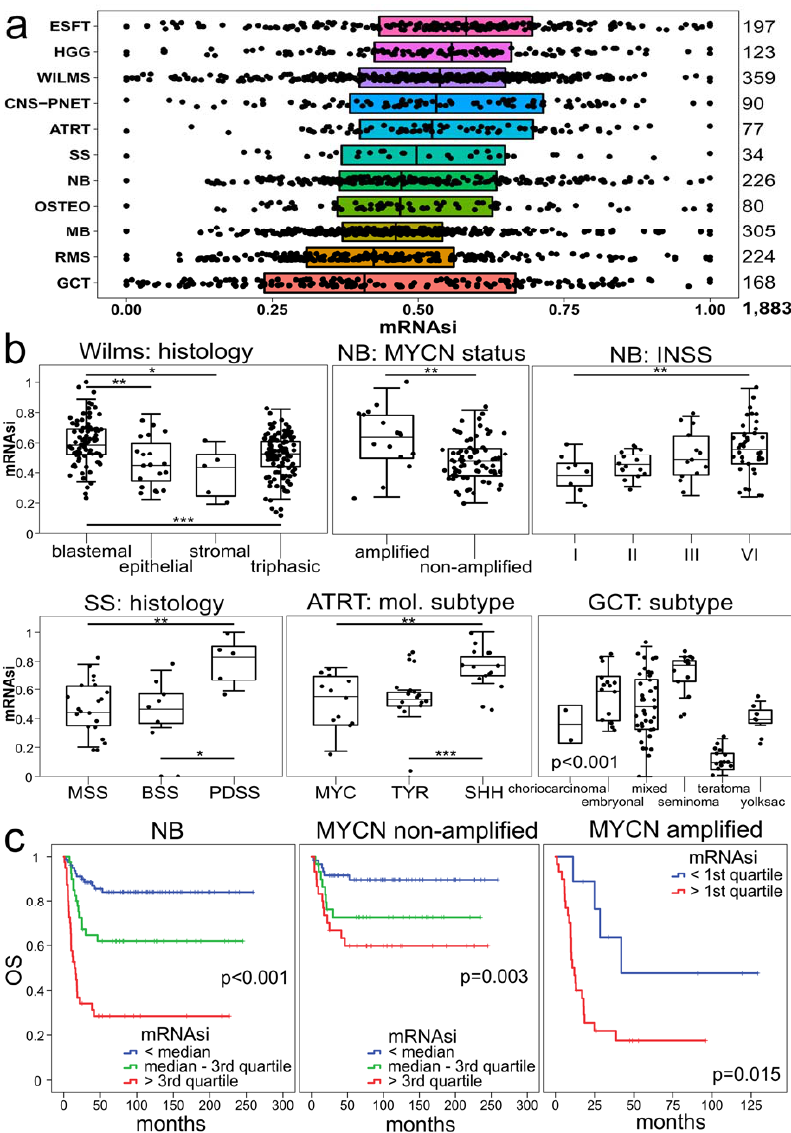
Figure 3. ( a ) Stemness index scores (mRNAsi) across different childhood cancers (CIBERSORT-cohort) ranging from 0 (low) to 1 (high). Dots represent individual pediatric tumors. The median was significantly different between tumor types ( p < 0.001, Kruskal–Wallis test). ( b ) mRNAsi depends on the histologic, molecular and clinical subtype in WILMS, NB, SS, ATRTs and GCT (individual GSE study sets). Blastemal histology is associated with higher stemness indices compared to other histological subtypes in WILMS (GSE31403, n = 220). MYCN-amplified neuroblastomas are associated with higher stemness indices (GSE16476, n = 88). Higher mRNAsi indices are found in stage IV NBs compared to lower stages (GSE16476, n = 88). Poorly differentiated SS (PDSS) show significantly higher mRNAsi scores than monophasic and biphasic SS (MSS and BSS) (GSE20196, n = 34). SHH-ATRTs have higher stemness indices than MYC-ATRTs and TYR-ATRTs (GSE70678, n = 42). Seminomas and embryonal GCTs show higher mRNAsi values compared to other GCT subtypes by group variance testing (GSE3218, n = 90) ( p < 0.001, Kruskal–Wallis test). For all other comparisons, a pairwise Mann–Whitney U test was performed, indicated by bars and stars representing the level of significance: * p < 0.05, ** p < 0.01, *** p < 0.001. ( c ) A low mRNAsi is associated with longer OS independent of MYCN amplification. Kaplan–Meier analyses comparing survival with low (blue), intermediate (green) and high (red) mRNAsi values. Left: entire cohort ( n = 162), middle: MYCN non-amplified ( n = 122), right: MYCN amplified ( n = 39) NBs. Abbreviations: atypical teratoid rhabdoid tumor, ATRT; Ewing’s sarcoma family of tumors, ESFT; germ cell tumors, GCT; high grade gliomas, HGG; medulloblastomas, MB; neuroblastoma, NB; osteosarcoma, OSTEO; CNS-PNETs; rhabdomyosarcoma, RMS; synovial sarcomas, SS; Wilms tumors, WILMS; monophasic synovial sarcoma, MSS; biphasic synovial sarcoma, BSS; poorly differentiated synovial sarcoma,